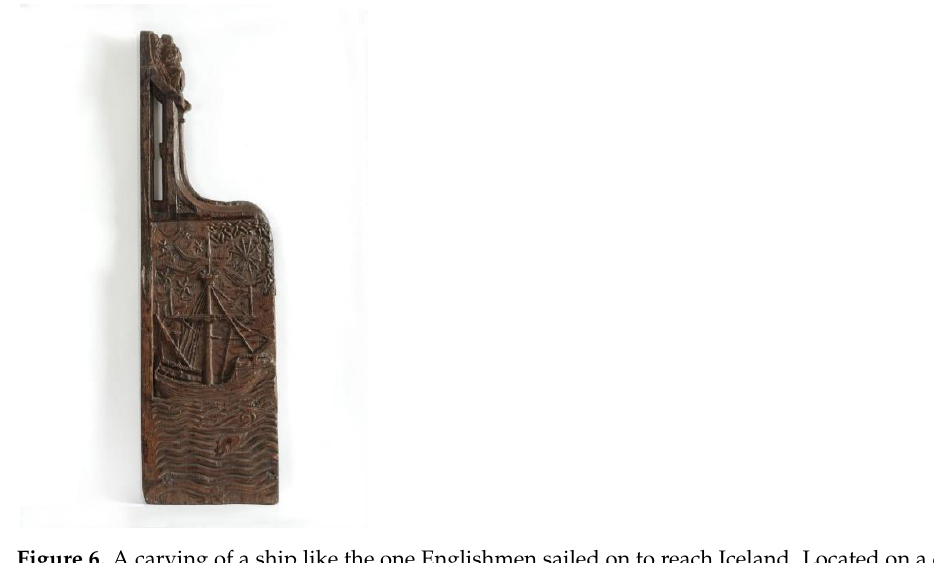
Figure 6. A carving of a ship like the one Englishmen sailed on to reach Iceland. Located on a church bench in St Nicolas Chapel in Bishops Lynn (© Victoria and Albert Museum, London).